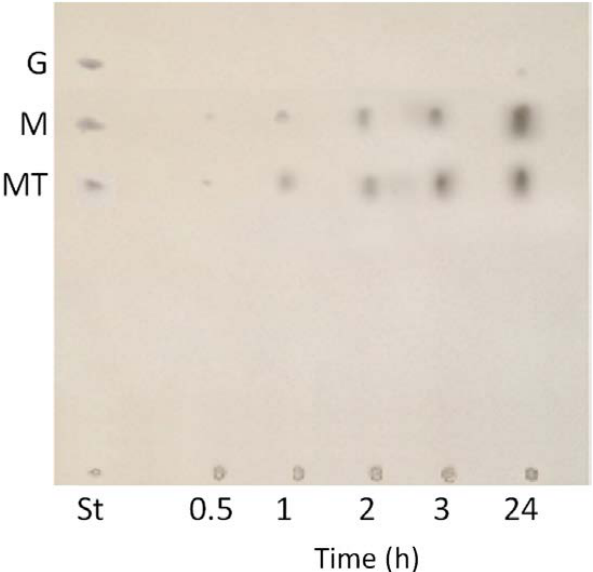
Figure 2. Thin-layer chromatography of the reaction products of soluble starch hydrolyzed by the purified α-amylase. Hydrolysis times were 0.5, 1, 2, 3 and 24 h. Standards (St) were a mixture of 1 mg/mL of glucose (G), maltose (M), maltotriose (MT).